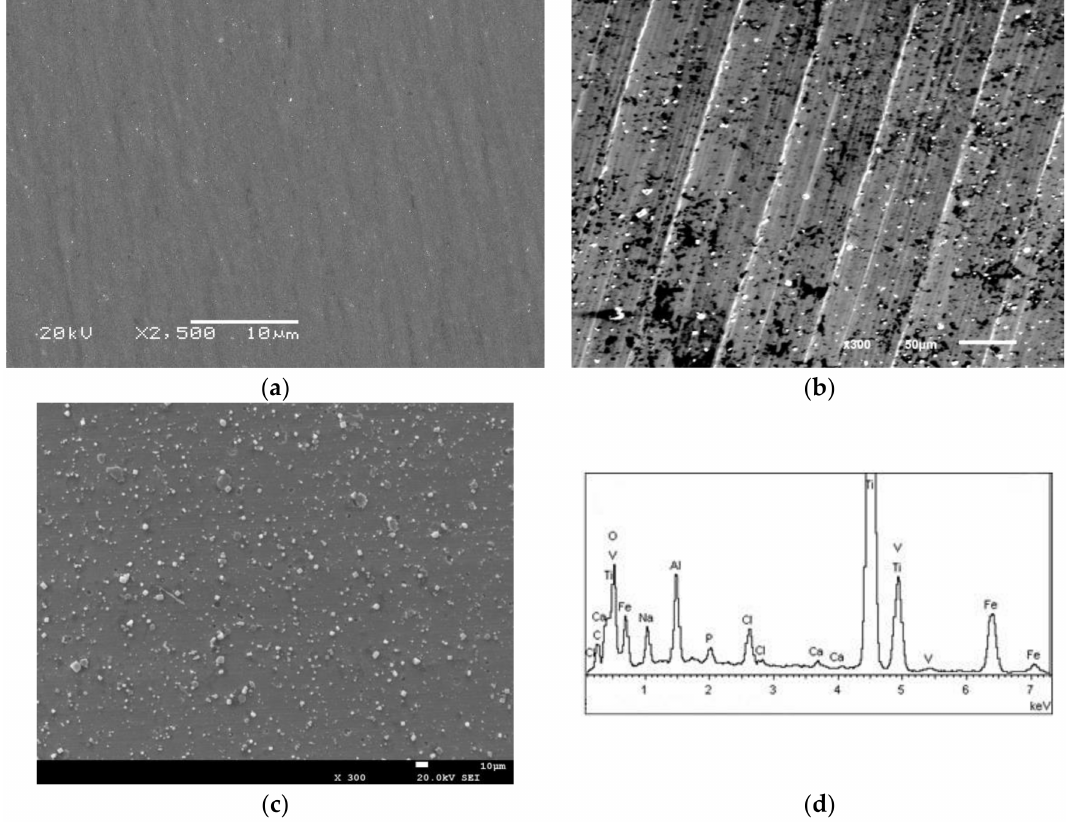
Figure 7. Observation of the surface subjected to SBF for 2 weeks: ( a ) IS; ( b ) UNSM; ( c ) UNSM-TiN ( d ) energy-dispersive X-ray spectroscopy (EDX) analysis of white